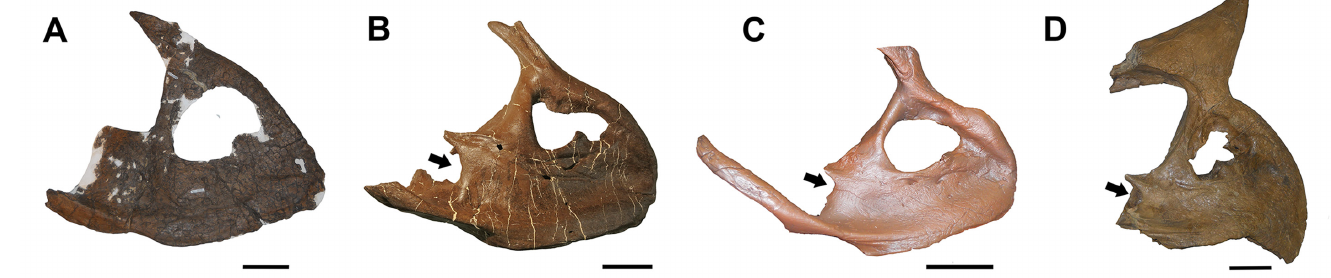
Figure 5. Premaxillae in lateral view. A) TMP 2002.057.0007, holotype of Eotriceratops (mirrored). B) MOR 1122 7-22-00-1. C) Partially reconstructed cast of MOR 1120, Triceratops horridus subadult from L3. D) MOR 1625, Triceratops prorsus young adult from U3. The premaxilla of MOR 1625 is fused to the rostral bone, nasal, and epinasal. Arrows highlight the recess positioned ventromedial to the strut of the triangular process. Scale, 10